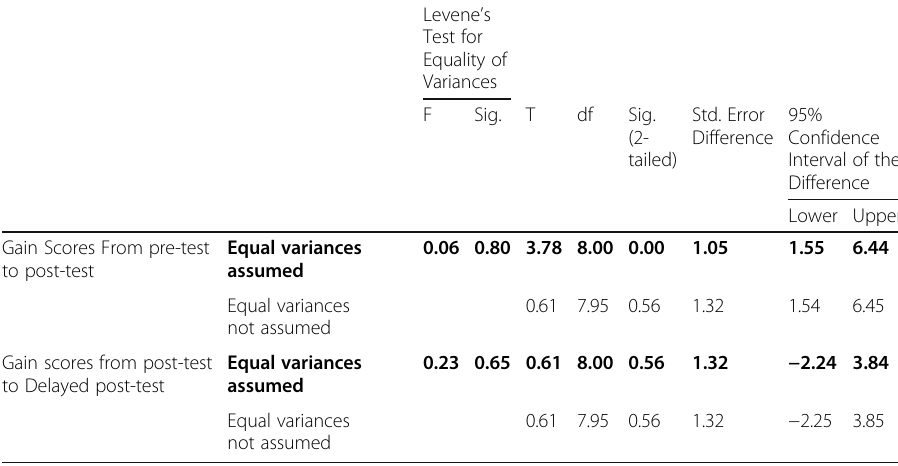
Table 5 Independent Sample t-test of Gain Scores from Pre-test to Post-test and Post-test to Delayed